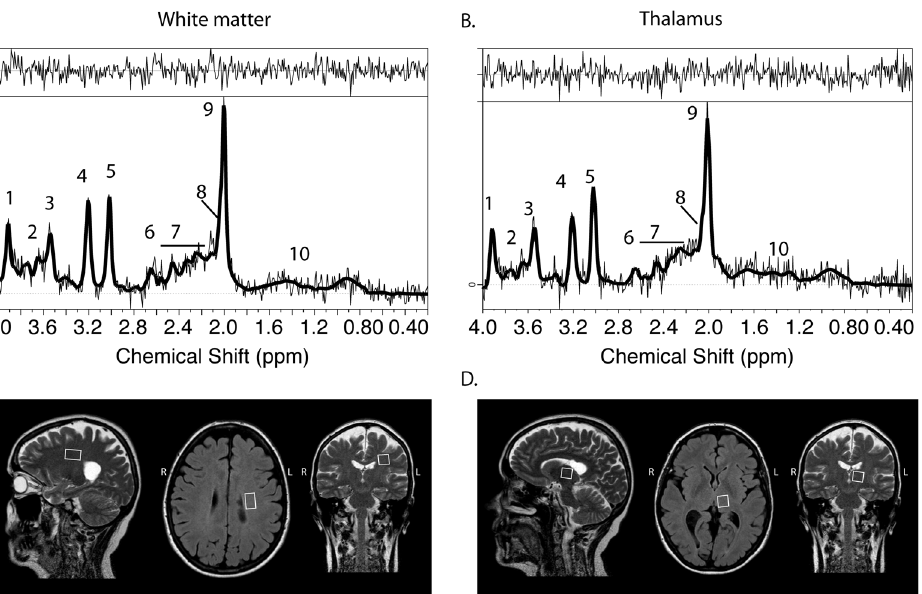
Figure 1. Typical spectra of white matter (A) and thalamus (B) of patient diagnosed with CDMS with no visible T2-lesions (MRIneg, female, 57 years old). Placement of MRS single volume of interest in white matter (C) and thalamus (D). Assignments of spectral resonances: 1, total Creatine (-CH2-); 2, Glutamate and Glutamine (CH- a ); 3, myo-inositol; 4, total Choline ((-CH2)3); 5, total Creatine (-CH3); 6, N-acetylaspartate (CH2); 7, Glutamate and Glutamine (CH- c / b ); 8, N-acetylaspartate-glutamate (CH3); 9, N-acetylaspartate (-CH3); 10,